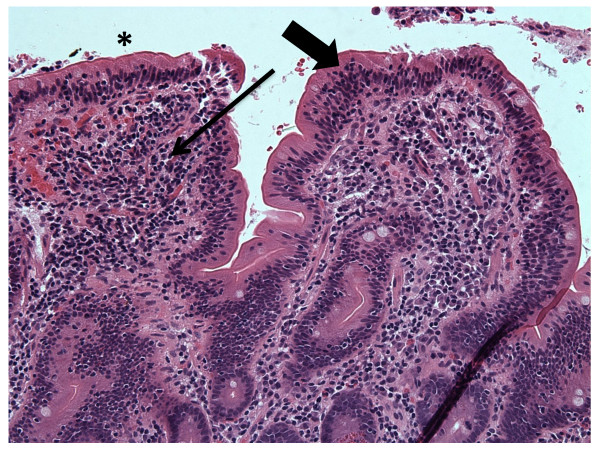
Duodenal biopsy obtained at the same time as in figure 3, but from a different region demonstrating abnormal tissue with blunted architecture (IEL and LP compartments marked by large and small arrows, respectively).